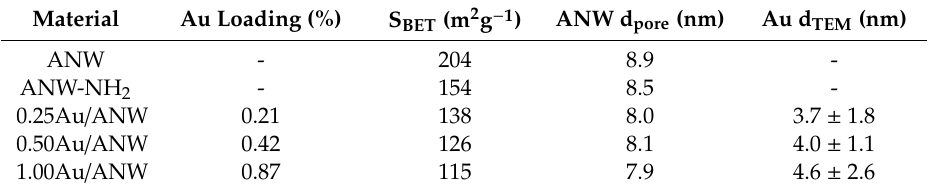
Table 1. Physicochemical characterization data obtained by atomic absorption spectrometry (AAS), N 2 isotherms and transmission electron microscopy (TEM) for the pristine ANW support, ANW-NH 2 and xAu/ANW catalysts.